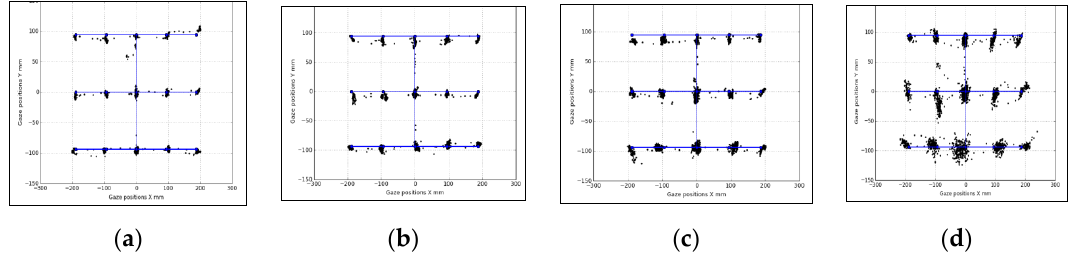
Figure 11. Data from user distance experiments: Desktop ( a ) 50 cm, ( b ) 60 cm, ( c ) 70 cm, and ( d ) 80 cm.